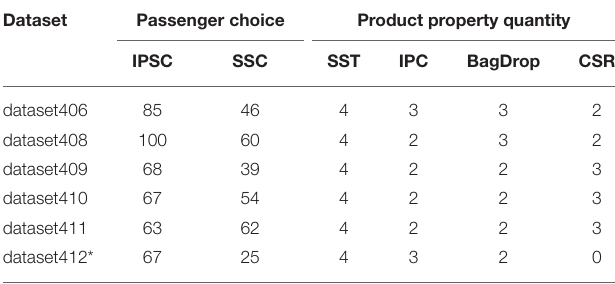
TABLE 1 | Experimental